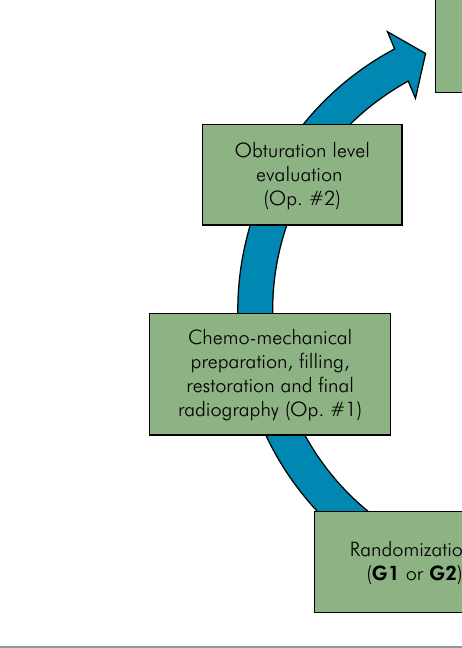
Figure 1. Summary of clinical